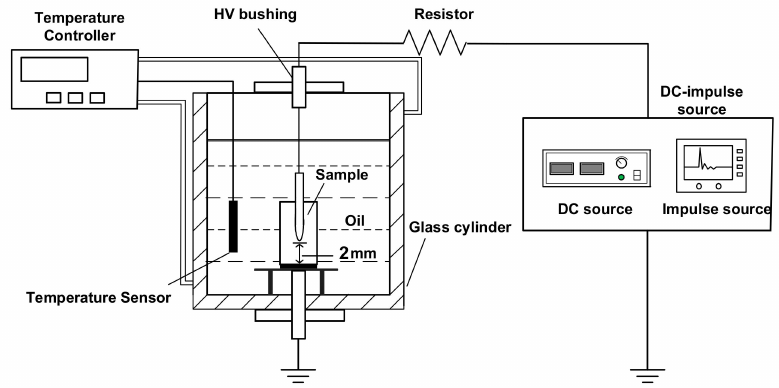
Figure 2. Schematic diagram of experimental setup.